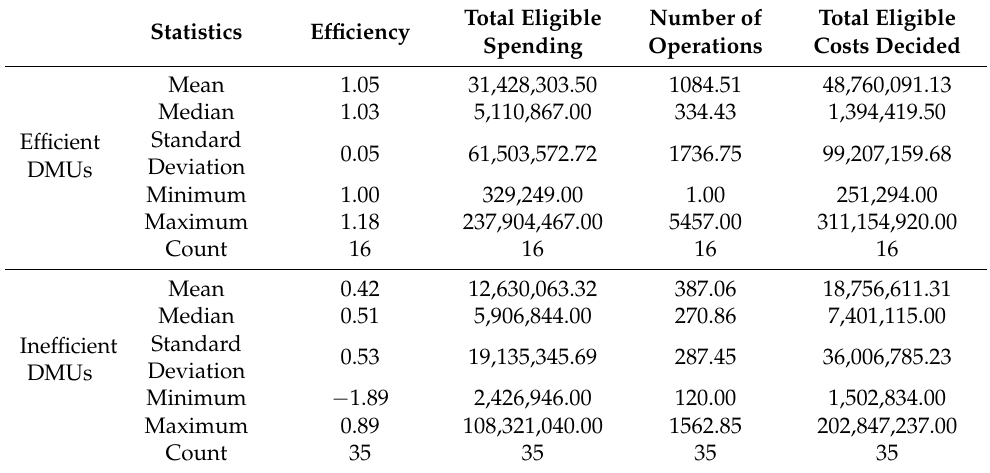
Table 12. Descriptive statistics of the results obtained both for efficient and inefficient OPs with adjusted